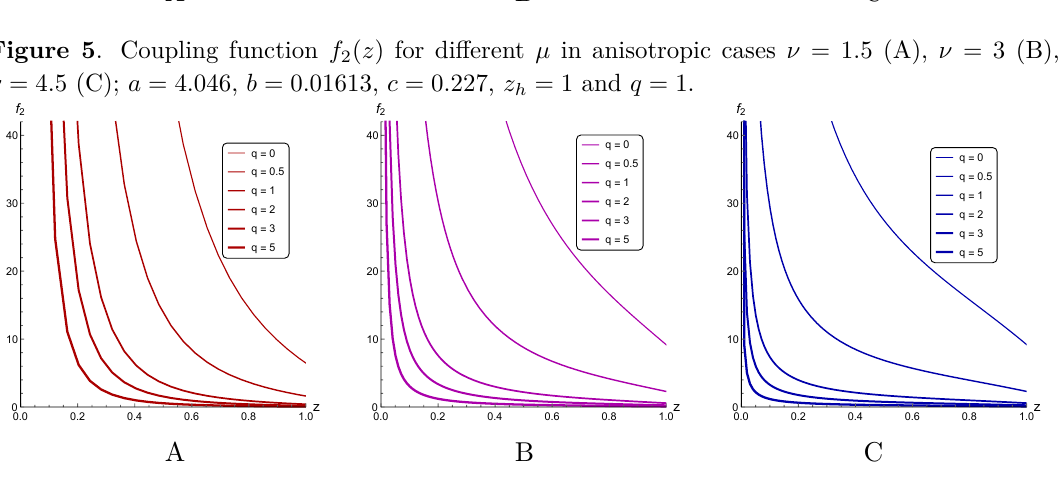
Figure 6 . Coupling function f 2 ( z ) for different q in anisotropic cases ν = 1 . 5 (A), ν = 3 (B), ν = 4 . 5 (C); a = 4 . 046 , b = 0 . 01613 , c = 0 . 227 , z h = 1 and µ = 1 .